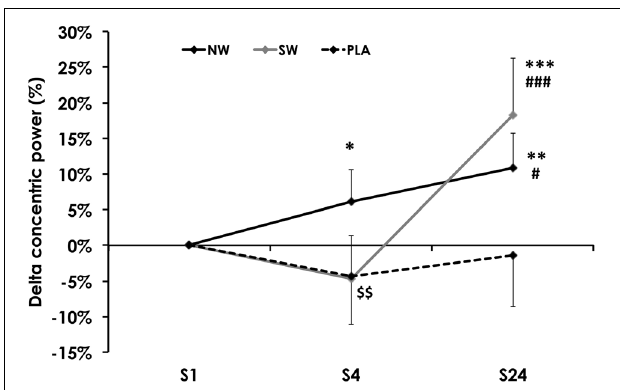
FIGURE 3 | Variation of the concentric power, measured before the 1st (S1, week 1), 4th (S4, week 2), and 24th (S24; week 12) electrostimulation (ES) training session. For the sake of clarity, values are expressed as the relative variation from S1. Significantly different from S1: ∗ p < 0.05, ∗∗ p < 0.01, ∗∗∗ p < 0.001. Significantly different from S4: # p < 0.05, ### p < 0.001. Significantly different from NW: $$ p < 0.01.